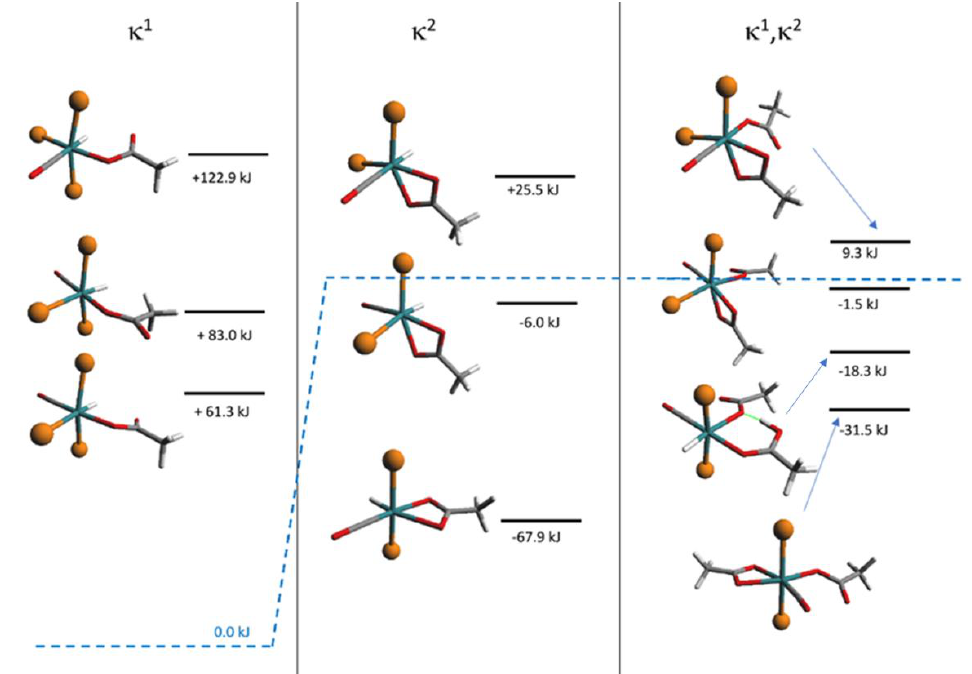
Scheme 6. Calculated DFT free energies (relative to 1 + 2 AcH, blue dashed line) for the reaction intermediates shown above and H-bonded postulated isomers of similar energy.